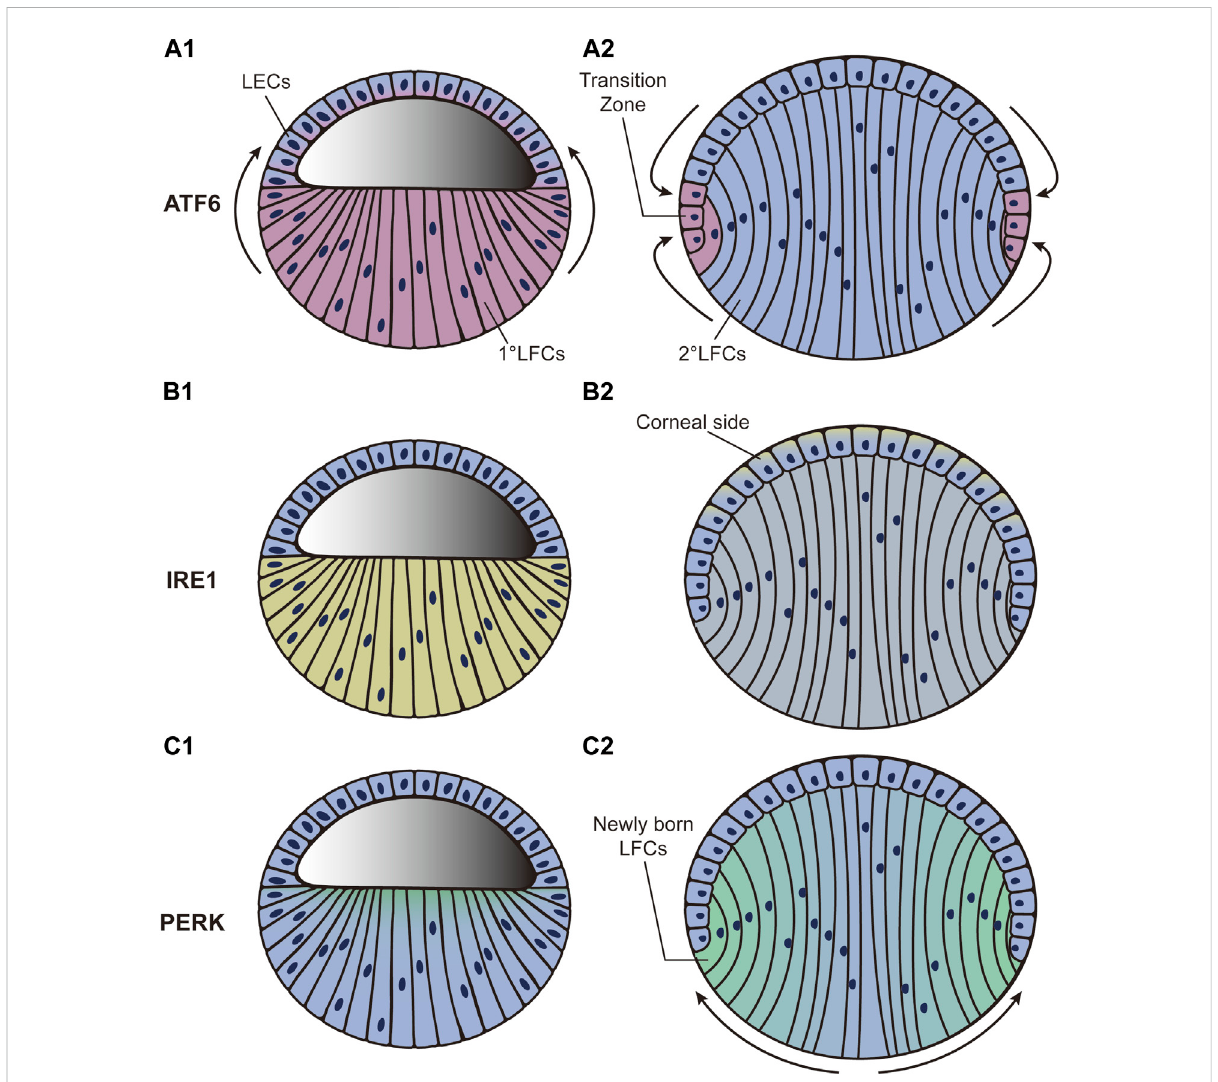
DynamicdistributionofthreeUPRpathwaysduringthethirdphaseoflensdevelopment. “ Blue ” referstolenscells; “ red, ”“ yellow, ” and “ green ” in A, B, and C refer to ATF6, XBP1, and PERK expression, respectively. (A 1 – A 2 ) : ATF6 expression level increases sharply in LFCs and gradually diffuses to LECs.Bytheendoflensdevelopment,thehighestexpressionlevelofATF6isdetectedaroundthetransitionzone. (B 1 – B 2 ) :XBP1expressionisinitially increased in LFCs. It then decreases in LFCs but increases in LECs. By the end of development, the highest expression level of XBP1 is found in LECs adjacent to the corneal epithelium. (C 1 – C 2 ) : PERK expression level fi rst appears at the apical tips of all LFCs and then accumulates predominantly in newly born LFCs while declining to nothing in central LFCs as development proceeds. LECs: lens epithelial cells; LFCs: lens fi ber